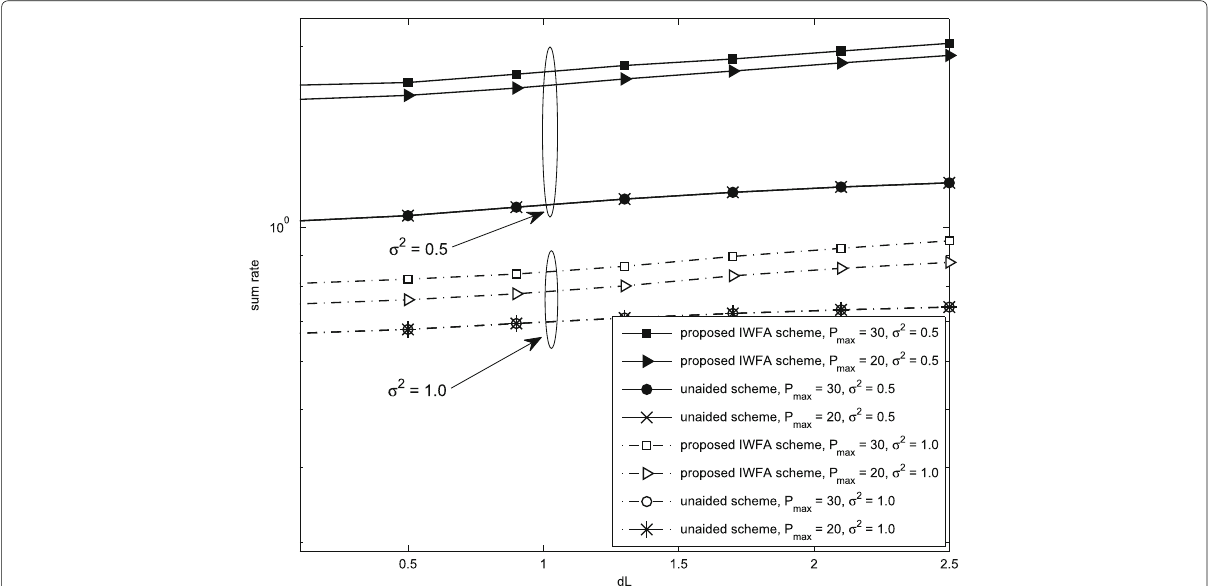
Fig. 3 The sum rate as a function of the interlink distance dL in a two-link system. Figure 3 provides the results of sum rate versus the interlink distance dL . Each link represents the sum rate under the different interlink distance. And the different types lines represent the proposed IWFA scheme and the unaided scheme under different conditions of P max ∈ { 20 dB ,30 dB } and σ 2 ∈ { 0.5,1.0